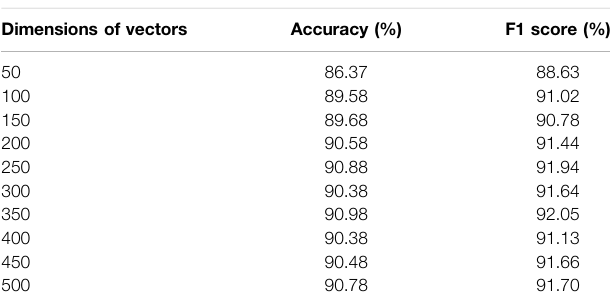
TABLE 2 | Results of the classi fi